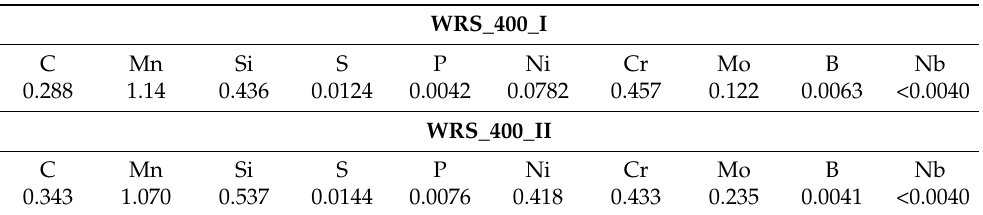
Table 4. Chemical composition of the tested steels [mass%].